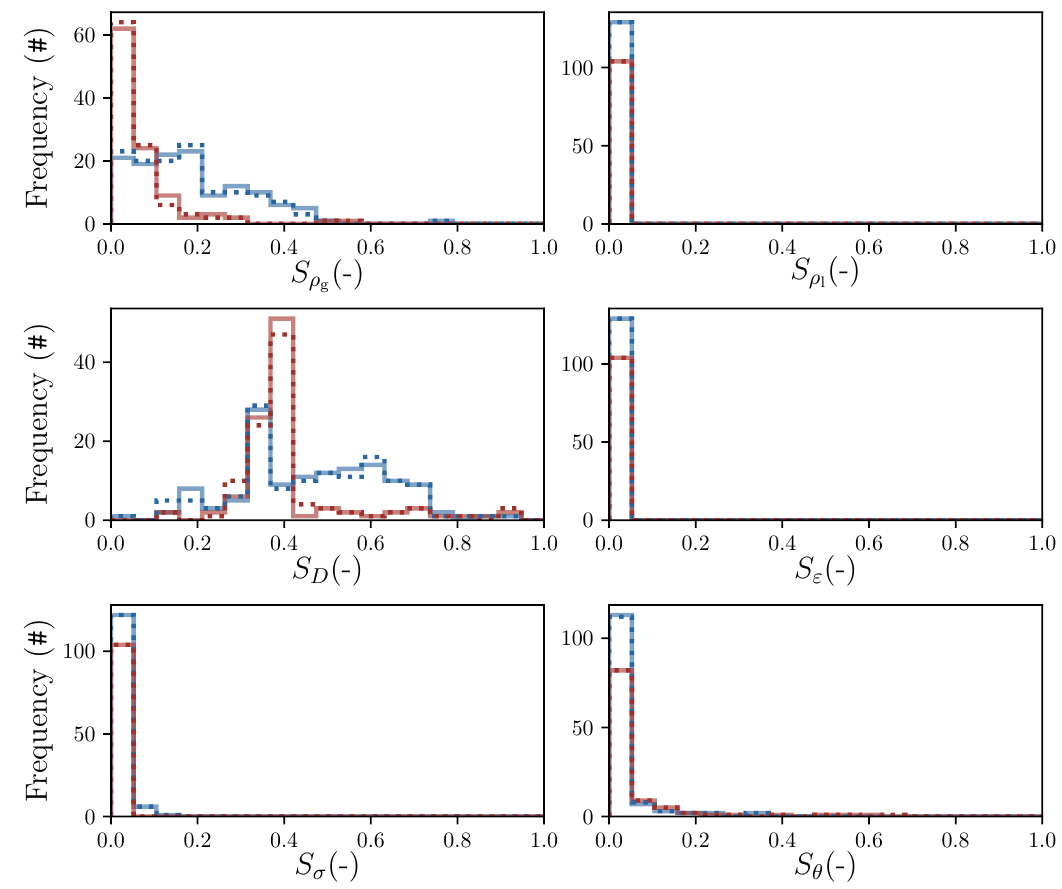
Figure 5. Frequency histograms of the holdup sensitivity estimates across 233 experiments. The sensitivity distribution for one input variable is given in each panel. The experiments are categorized as slug (blue) or stratified (red) and we compare estimates from Monte Carlo (solid lines) and PC